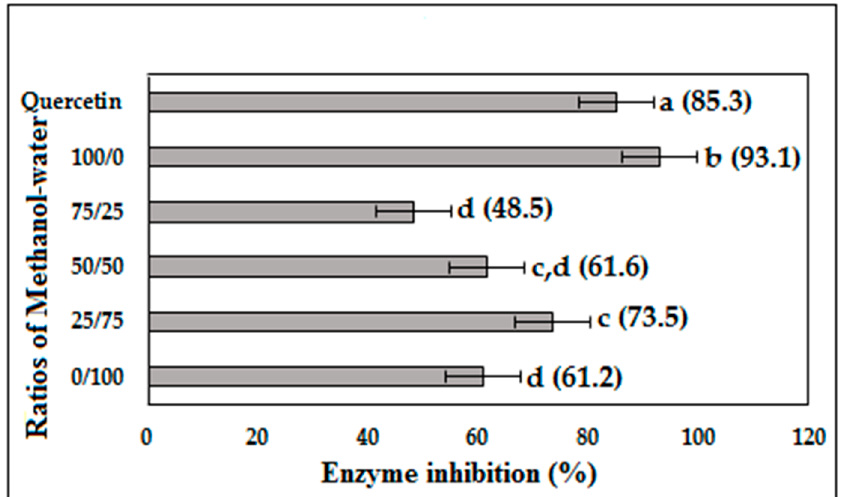
Figure 1. Percentage of α -glucosidase inhibition at the concentration of 10 µg/mL of P. malayana leaves extracts. The values that do not share the same letter are significantly different ( p < 0.05), as measured by Tukey’s comparison test.